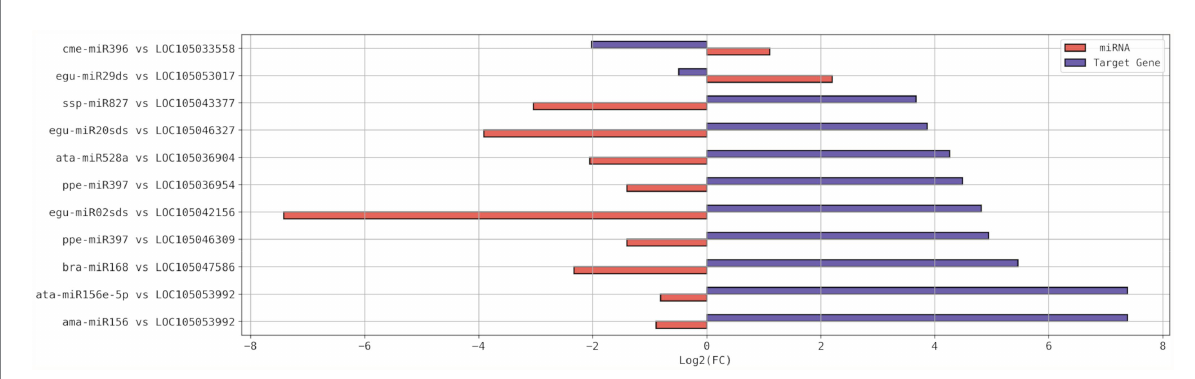
FIGURE 4 Expression profiles in Log 2 (FC) of the differentially expressed (DE) miRNAs and their respective DE putative target gene(s), resulted from submission of young oil palm plants to drought stress. FC, Fold